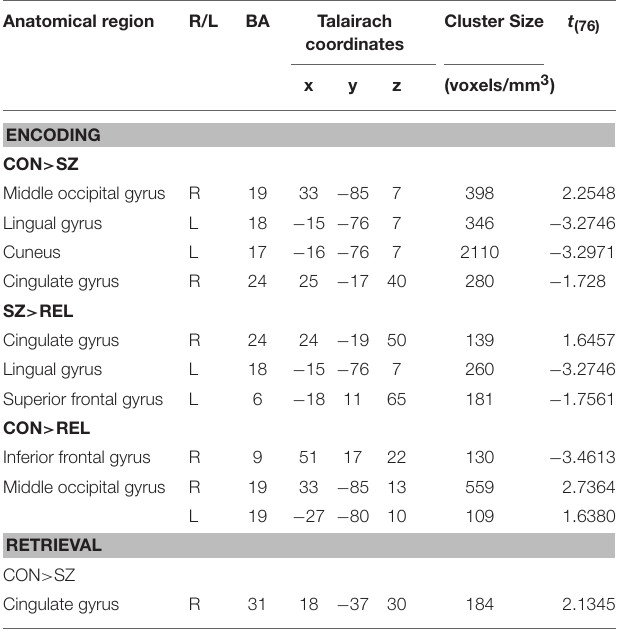
TABLE 3 | Statistical group comparisons of functional brain activation differences between groups for successful encoding and retrieval ( > ITI). Anatomical